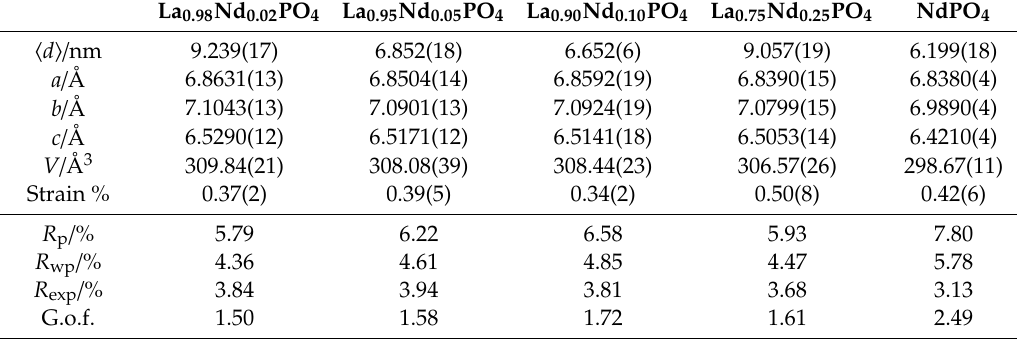
Table 1. Average crystallite size estimates (cid:104) d (cid:105) , lattice parameters a , b , c , cell volume V and strain of nanocrystals according to Rietveld refinement on the XRPD patterns depicted in Figure 1. The numbers in brackets refer to the errors in the last digits, respectively. The quality parameters for the Rietveld refinement are given below: Profile factor R p , weighted profile factor R wp and optimum expected R exp factor together with the final goodness of the fit (G.o.f.) to the structural input of the monazite structure type.